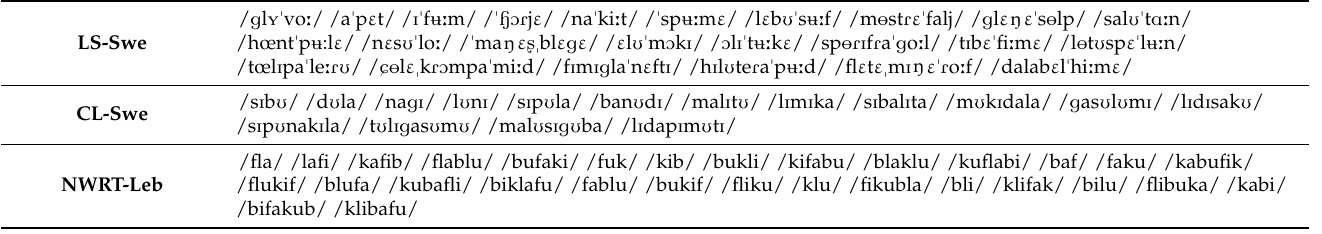
Table A1. All items in the NWR tasks: the LS-Swe (language-specific Swedish), the CL-Swe (crosslin- guistic Swedish), and the NWRT-Leb (Non-word repetition task Lebanese).